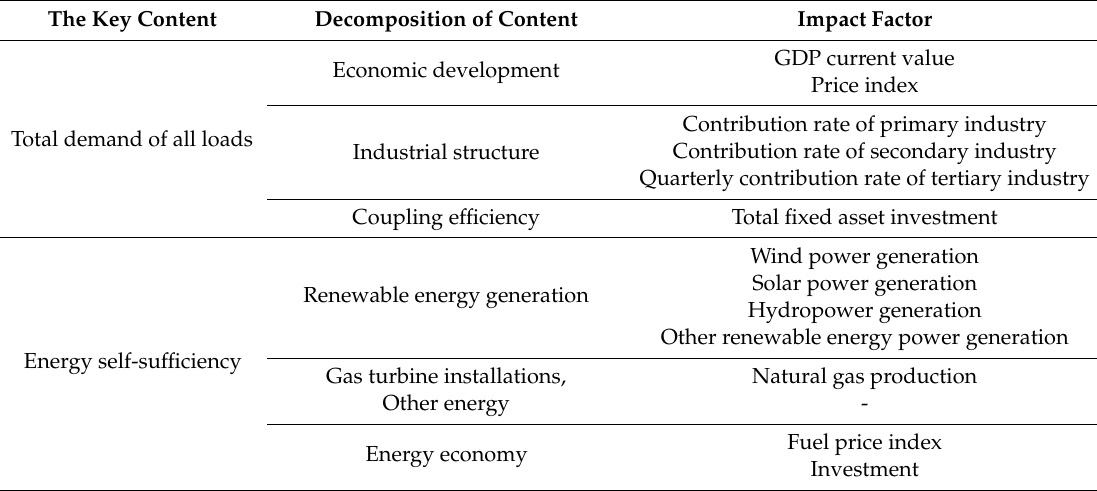
Table 3. Key influencing factors of load demand under the scenario of multi-energy